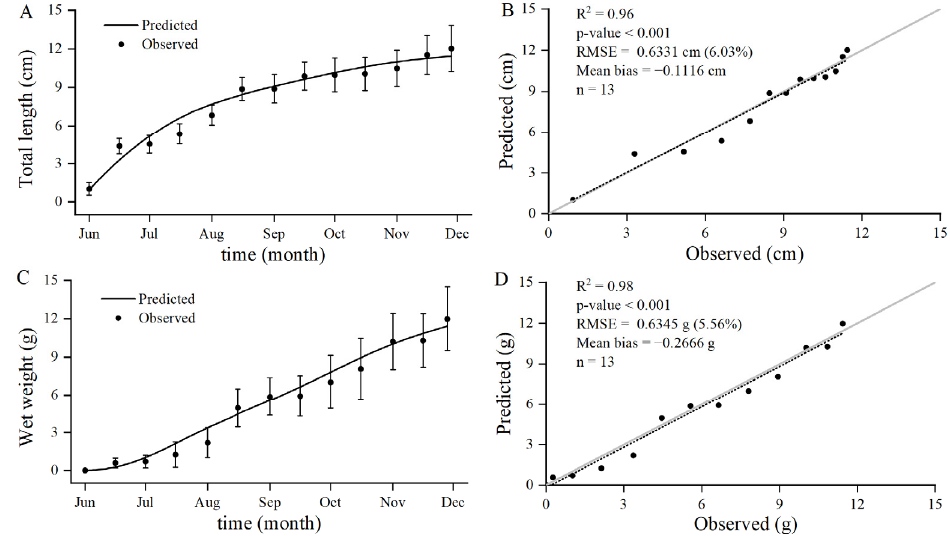
Figure 3. Modelled (lines) and observed (circles with bars for standard deviation) growth in terms of total length ( A ) and wet weight ( C ) for kuruma shrimp in an integrated marine aquaculture pond, and validation for total length ( B ) and wet weight ( D ) growth modeled with several goodness-of-fit